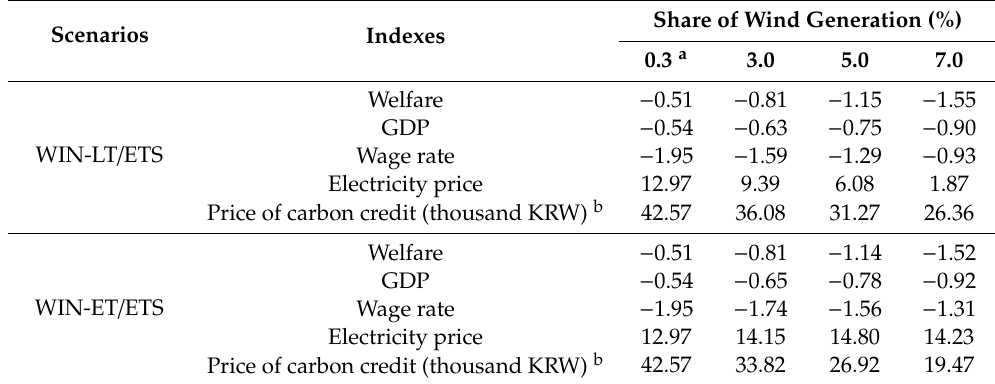
Table 13. Macroeconomic e ff ects of wind generation expansion with emission regulations (% changes from the base